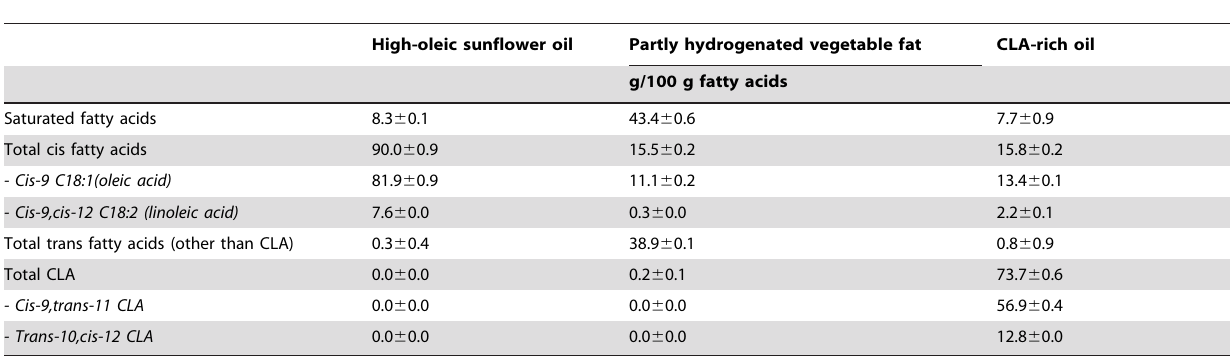
Table 1. Fatty acid composition of the oils and fats used to produce the experimental margarines and yoghurts.